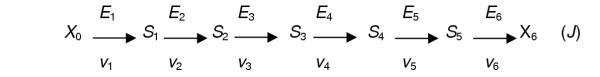
A segment of a model metabolic pathway. This diagram shows those features, discussed in the text, that permit a systemic analysis of the response of any variable of a metabolic system (e.g. a flux J or the concentration of any intracellular metabolite S) to changes in any one parameter of the system (e.g. an enzyme activity). Each S is an intracellular metabolite; each X is an extracellular metabolite. In a diploid cell, every E stands for a pair of enzymes (allozymes), each specified by one of the two alleles at a gene locus. Each E is then a locus of catalytic activity within a system of enzymes; each v stands for the individual reaction rates catalysed jointly by a pair of allozymes in a diploid cell. Either or both allozymes at such a locus may be mutated.